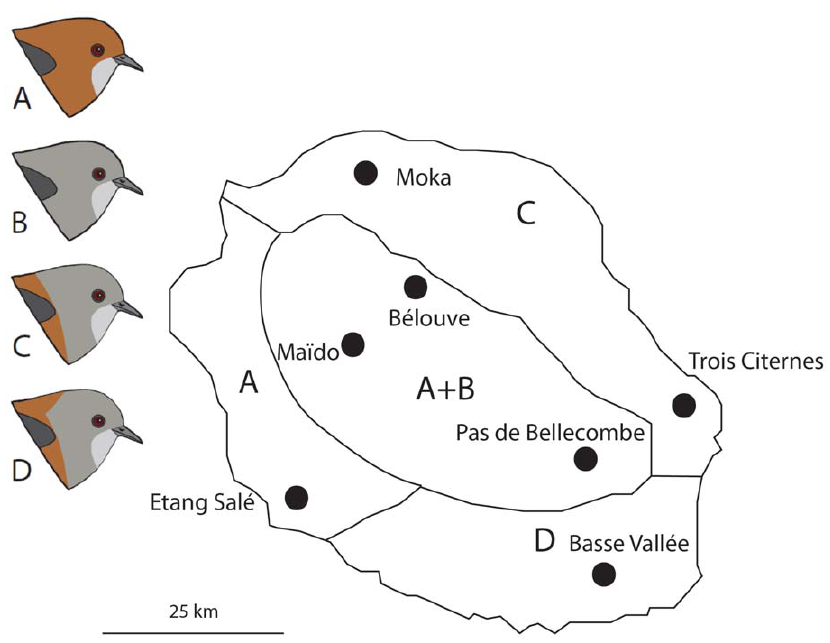
Figure 1. Map showing Z.borbonicus sampling localities, and distribution of the four morphs on Re´union. Letters correspond to the different plumage morphs: A: Brown morph; B: Grey morph; C: Grey-headed brown morph; and D: Grey-headed brown-naped brown morph. For a more detailed description of pigmentation phenotypes, see [17]. Adapted from [18].